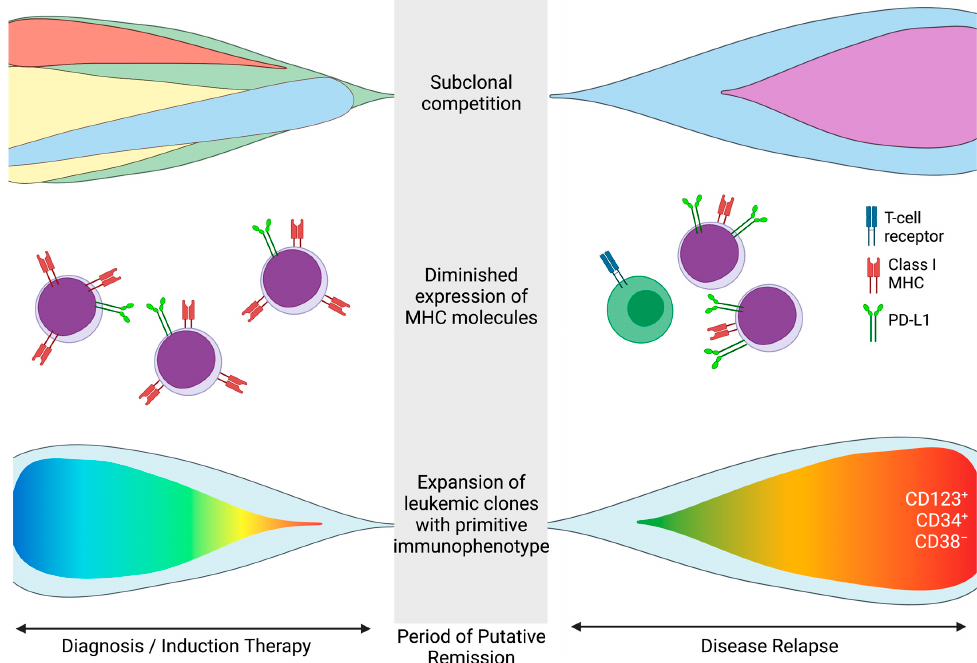
Figure 2. Mechanisms of acute myeloid leukemia relapse. The various schema depict three mechanisms of AML relapse delineated by NGS and flow cytometric techniques discussed in the text and include: ( top panel ) Mutational clonal heterogeneity is frequent at initial presentation. Chemotherapy ‐ resistant subclones may persist at the time of putative remission and expand to become a dominant population at relapse. ( middle panel ) Downregulation of crucial MHC genes/molecules on leukemic cells (red receptors) or upregulation of checkpoint molecules (green receptors) during the course of treatment or at the time of relapse may result in more effective AML immune evasion and contribute to loss of graft ‐ versus ‐ leukemia recognition by donor T cells (green cells with blue T cell receptors). ( bottom panel ) Immunophenotyping or different ‐ from ‐ normal flow cytometric techniques identify leukemic populations enriched for leukemia stem cells at the time of diagnosis. At the time of relapse, expansion of clones characterized by more primitive immunophenotypic signatures (CD123 + CD34 + CD38 − ) may reflect the development of chemotherapy resistance.